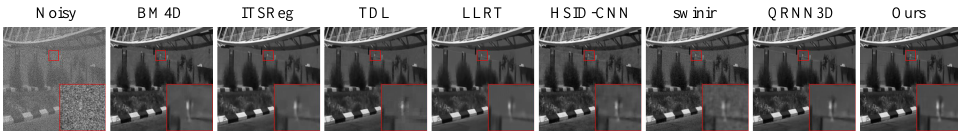
Figure 4. Gaussian ( σ = 50) denoising outputs at the 20th band of the image on the ICVL